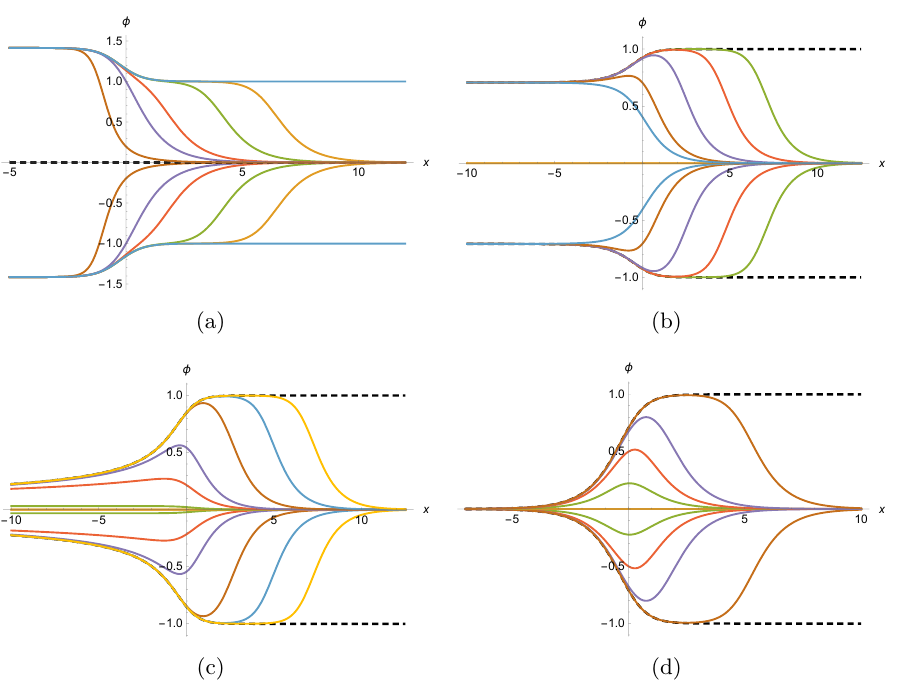
Figure 4 . Supersymmetric solutions of the deformed φ 6 theory for w ( x ) given in (4.12) with a = λ = w R = 1 . Solutions in φ < 0 region are obtained by φ → − φ . In each figure, vacuum solutions are depicted with dashed lines. (a) Plots for w = 2 . The topmost curve interpolates L √ √ between 2 and 1 and has energy E = 3 . The other solutions interpolating between 2 and 0 are 4 for c = 100 , 1 , 0 . 1 , 10 − 3 , and 10 − 5 , respectively from the left. The energy of these solutions are all E = 1 . (b) Plots for w = 1 . The dashed curves interpolating between ± 1 √ and 1 are vacuum L 2 2 solutions with negative energy E = − 3 . The other solutions interpolating between 1 √ and 0 are 16 2 −√ −√ −√ for c = 1 , − 1 , 2 + 10 − 2 , 2 + 10 − 4 , and 2 + 10 − 6 , respectively from the left. The energy of these solutions are all E = 1 . (c) Plots for w = 0 . The dashed curves interpolating between L 16 0 and ± 1 are vacuum solutions with negative energy E = − 1 . The other solutions all vanish as 4 x → ±∞ and are for c = 10 − 6 , 10 − 4 , 10 − 2 , 1 , 10 , 10 3 and ∞ , respectively from the top. The energy of these solutions are all zero. (d) Plots for w = − 1 . The vacuum solutions are dashed L curves interpolating between 0 and ± 1 with energy E = − 1 . The other solutions vanishing at both 4 spatial infinities are for c = 1 . 0001 , 1 . 1 , 2 , 10 , and ∞ , respectively from the top. The energies of these solutions are all